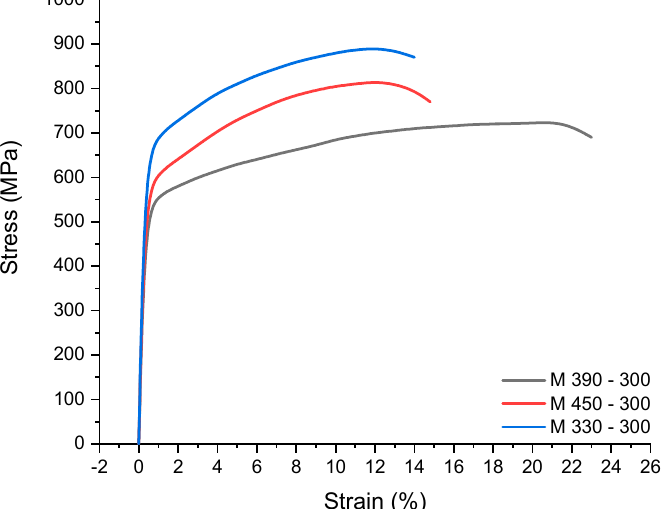
12. It can be observed that these steels do not present the yield point phenomena, which is characteristic of low interstitial alloy steels. This behavior can be explained taken into account the high dislocation density of ferrite due to the transformation of austenite to martensite [26] and the effect of substitutional alloying elements in ferrite such as Si and Al [27].